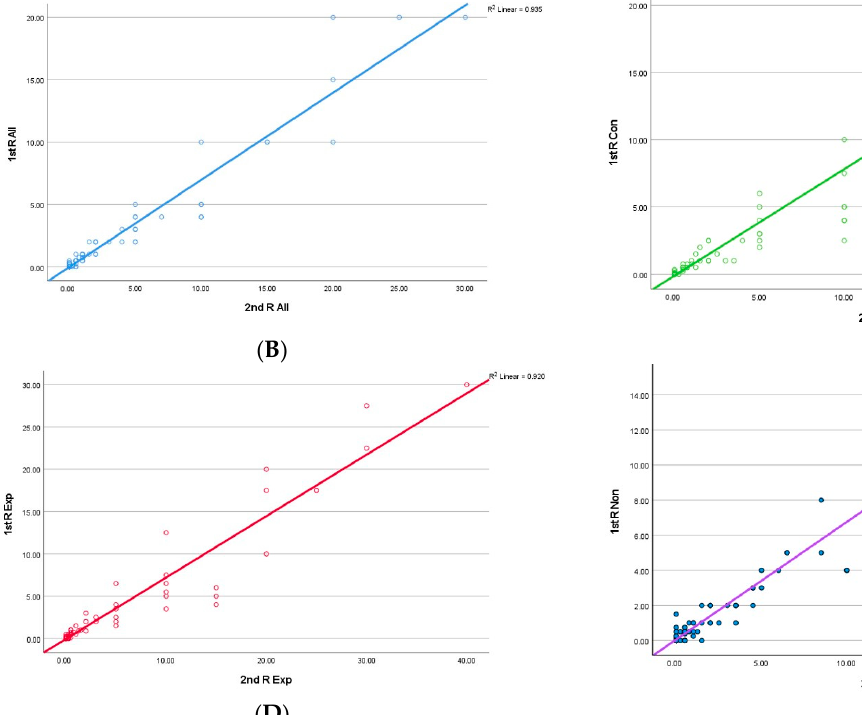
Figure 3. Scatter plot showing the distribution of the median percentage of PD-L1 in the four groups; experienced consultants (Exp; red line), non-experienced consultants (Con; green line) and all (All; blue line) participants. ( A ) The distribution of percentage scores among all scorers in both rounds; ( B ) All pathologists’ (including non-experts and trainees) percentage scores in both rounds (R 2 = 0.935); ( C ) All consultants’ (including experts and non-experts) percentage scores in both rounds (R 2 = 0.902); ( D ) Experienced consultants’ percentage scores in both rounds (R 2 = 0.920); ( E ) Non-experienced pathologists’ (including trainees) percentage scores in both rounds (R 2 = 0.89).